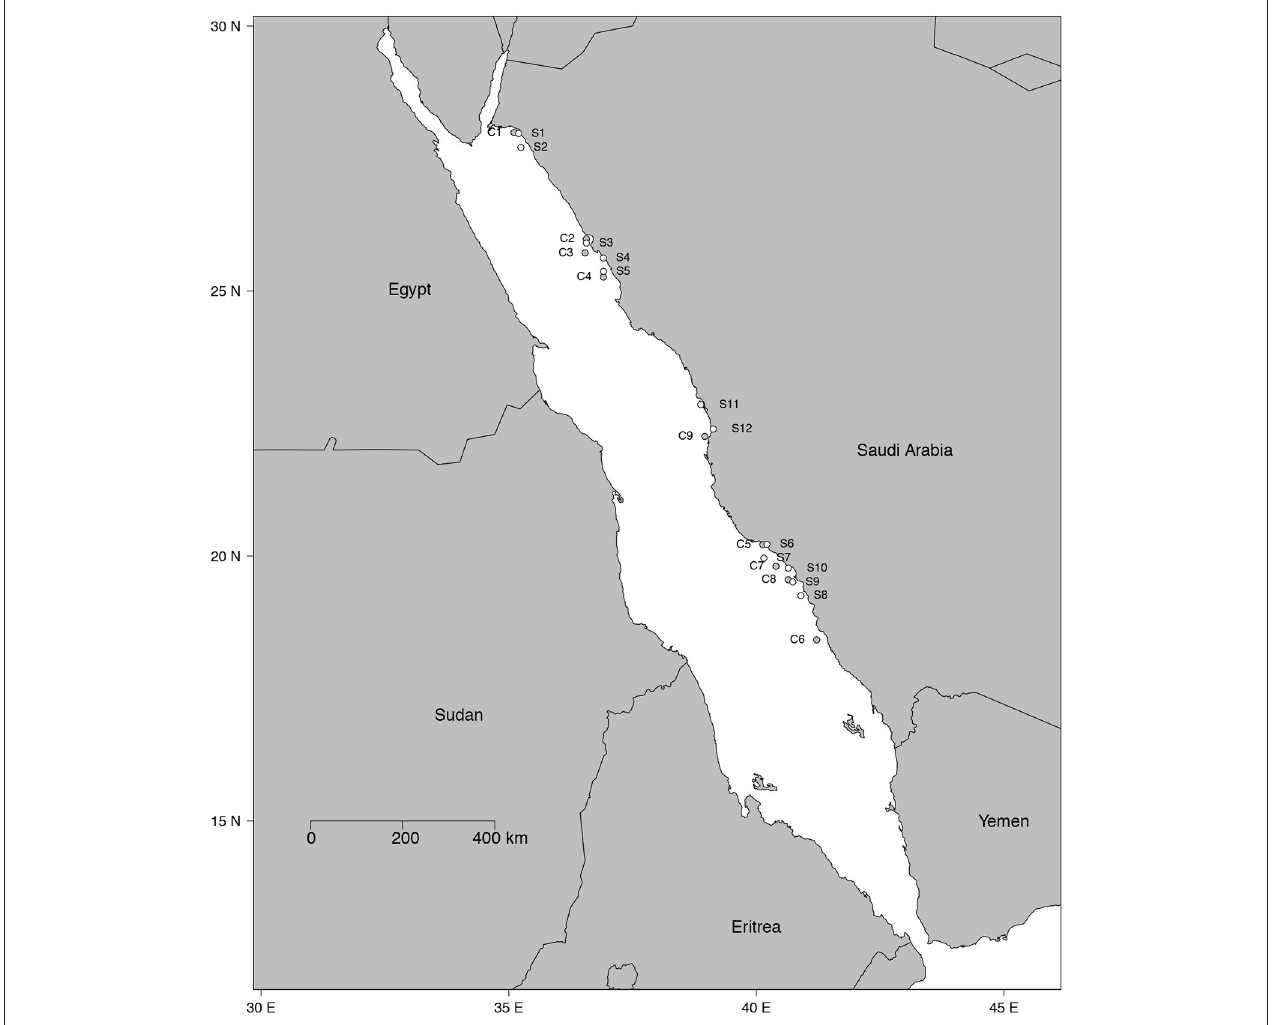
FIGURE 1 | Map of the 21 study sites. White dots denote the 12 seagrass meadows (from S1 to S12) and gray dots indicate the 9 shallow coral reefs (from C1 to